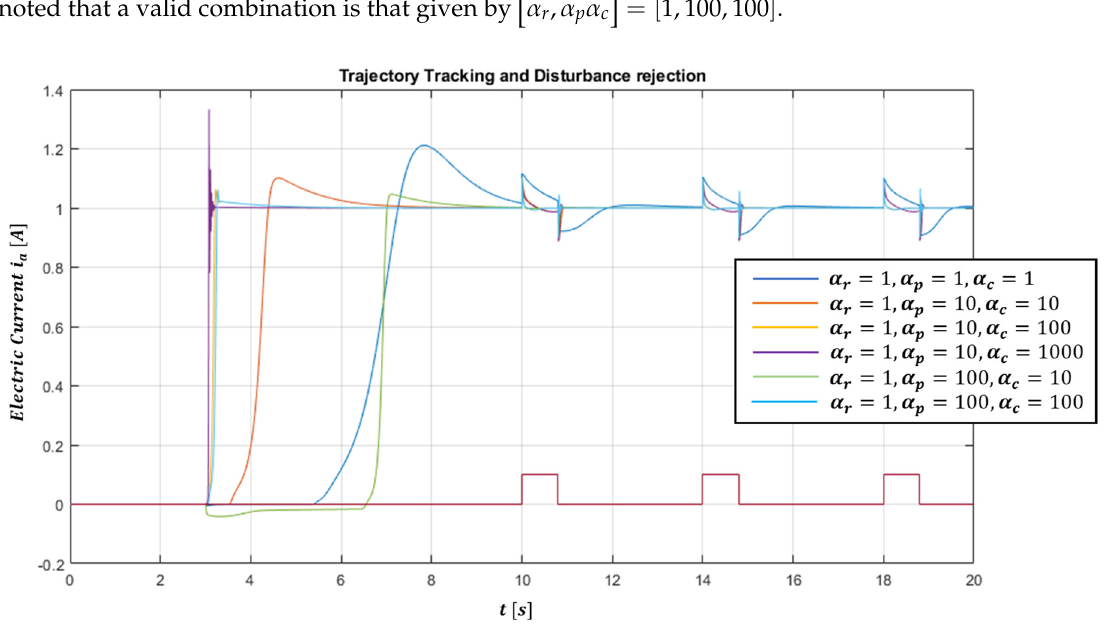
Figure 8. Step response and Disturbance rejection with respect to different learning rates combination.